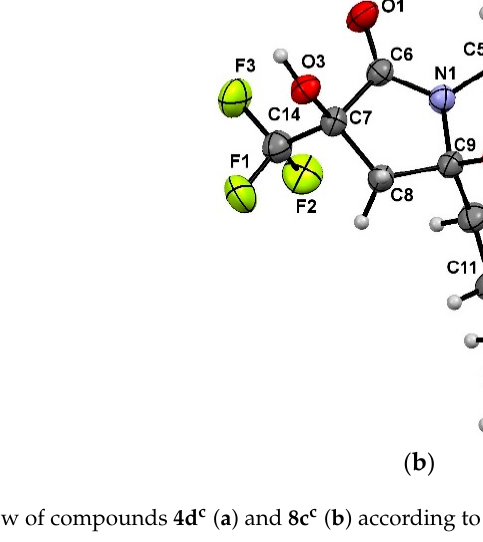
Figure 4. ( a ) The ORTEP view of compounds 5 tc according to XRD data; ( b ) crystal packing of com- pounds 5 tc with indication of intermolecular hydrogen bonds. For a pair of isolated diastereomers 5 tc , 5 cc (Figure 2), two-dimensional experiments 2D 1 H- 13 C HSQC and HMBC were performed, on the basis of which a complete assign- ment of signals in the 1 H and 13 C NMR spectra was made. The 1 H NMR spectrum of pyr- rolo[2,1- b ]oxazol-5-one 5 tc is characterized by the presence of doublet signals of the meth- ylene protons of the pyrrolidine ring H-7’’A and H-7’’B at δ H 2.99, 2.29 ppm ( Δ AB 0.70 ppm, 2 J 14.9 Hz) and propanoate substituent H-1’A and H-1’B at δ H 2.63, 2.20 ppm ( Δ AB 0.43